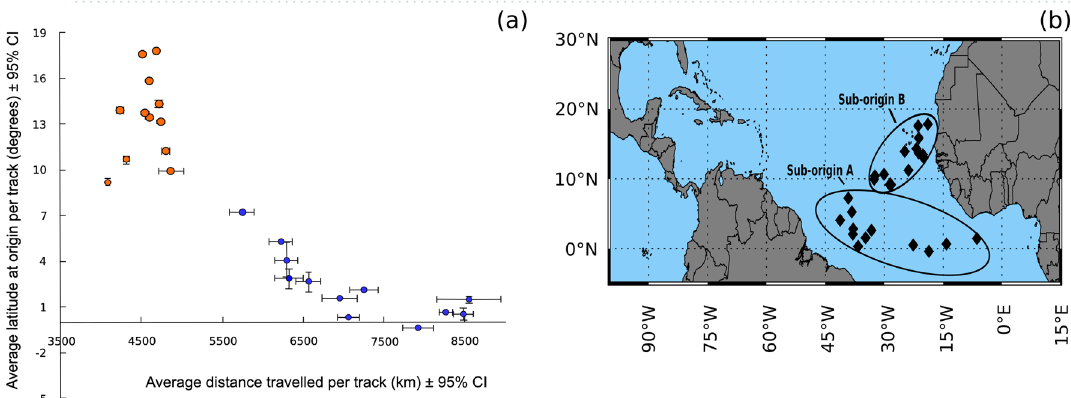
Figure 4. Sargassum sub-origins and transport pathway metrics within the Tropical Atlantic as determined from backtracking monthly Sargassum samples stranded in Barbados. Part ( a ) shows the average (± 95% CI) distance travelled per track and the average (± 95% CI) latitude of each origin for a given date. Blue dots indicate samples from sub-origin A and orange dots indicate samples from sub-origin B. Part ( b ) shows the two distinct sub-origins identified. Black square represents the average latitude at the origin of each track for a given date. Map was generated using IDL 8.8.1 (https:// www. l3har risge ospat ial. com/ Softw are- Techn ology/ IDL). All backtracks started from the Morgan Lewis beach, located on the east coast of Barbados and were run over a 365- day period using 100 particles. All averages represent mean value of the 100